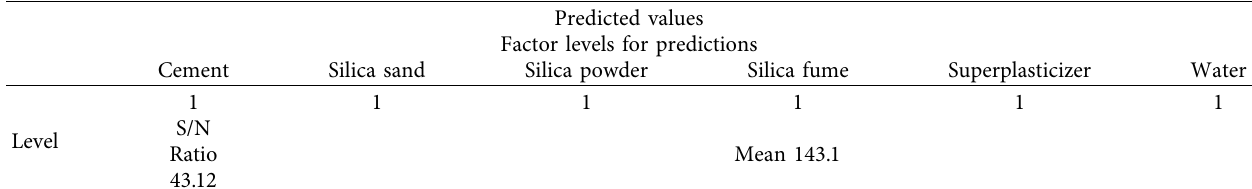
Table 17: RPC mix design predicted by Minitab for compressive strength.